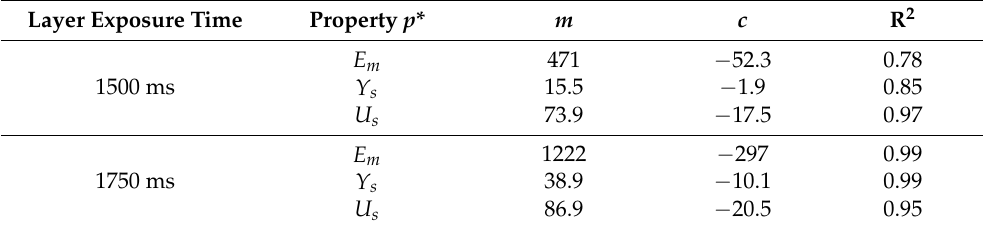
Table 4. Linear regression values with correlation coefficient for mechanical properties to measured relative density of BCC lattices with varied layer exposure time, according to Equation (3). Layer Exposure